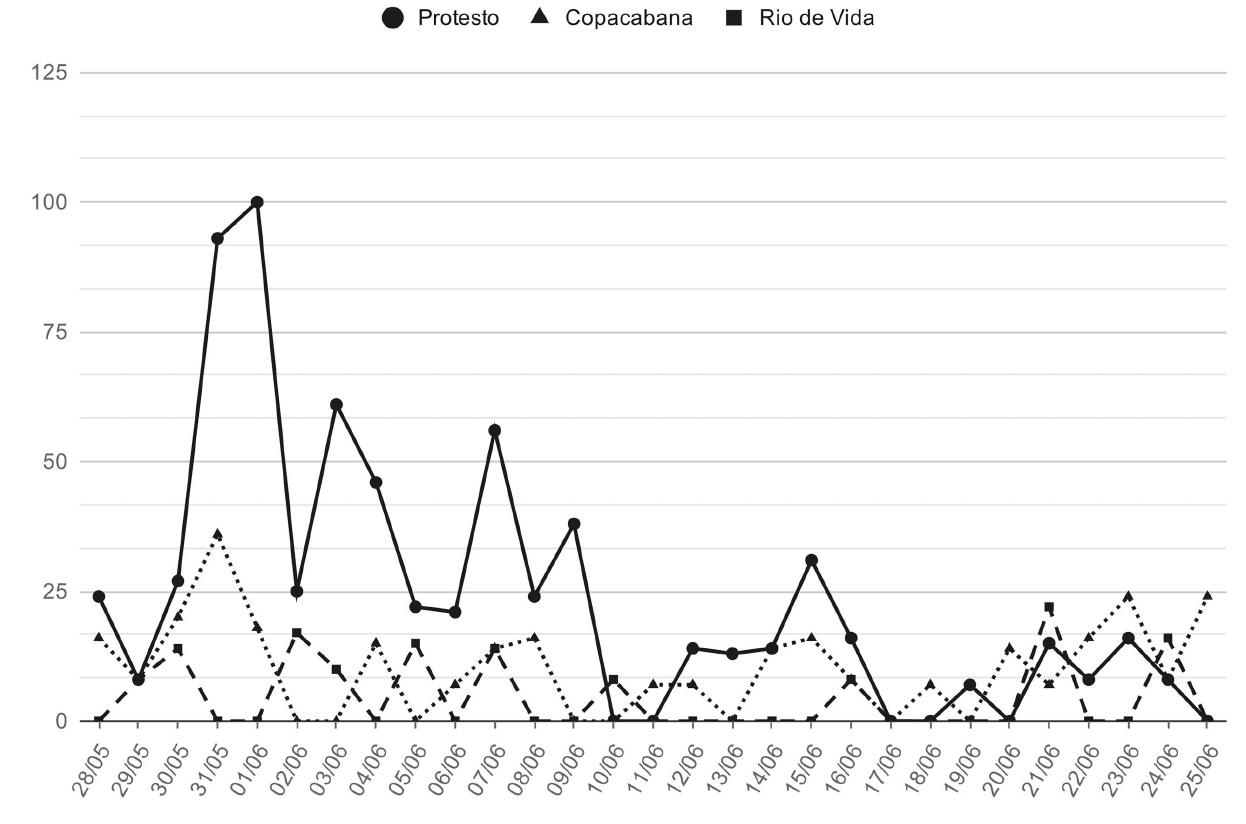
FIGURE 5 | Web Search for “protest,” “Copacabana,” and “Rio de Vida” between 5/28/20 and 6/25/20. https://trends.google.com/trends/explore?date=2020-05-11